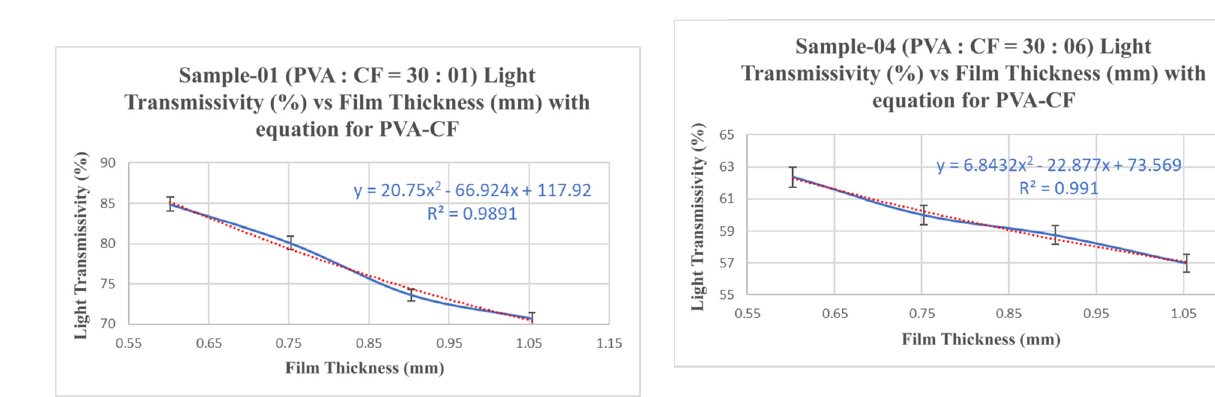
Figure 19: Sample - 04 ( CF:PVA = 0.6:30 ) light transmittance ( % ) versus fi lm thickness ( mm ) with equation for PVA - CF. The dotted lines represent the polynomial fi tted curve and the linear fi